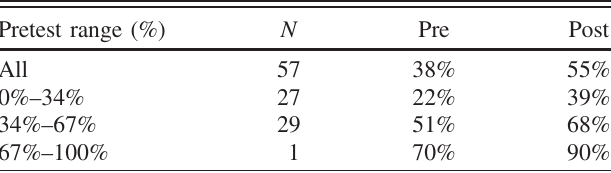
TABLE VIII. Percentage average total pretest and post-test scores (matched pairs) divided into three groups according to the pretest performance for students who did not work on the tutorial (nontutorial or comparison group) and only had lecture-based instruction in relevant content. The symbol N denotes the total number of students in each range who took both the pretest and post-tests.